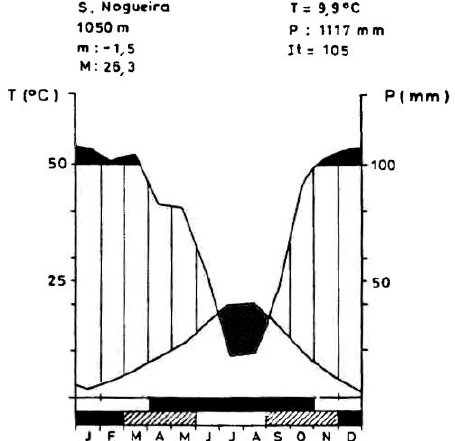
Figure 1. Climatic diagram of the site (Nogueira mountain), with annual precipitation (P), mean temperature (T), mean minimum temperature for the coldest month (m), mean maximum temperature for the hottest month (M), and termicity index (It).